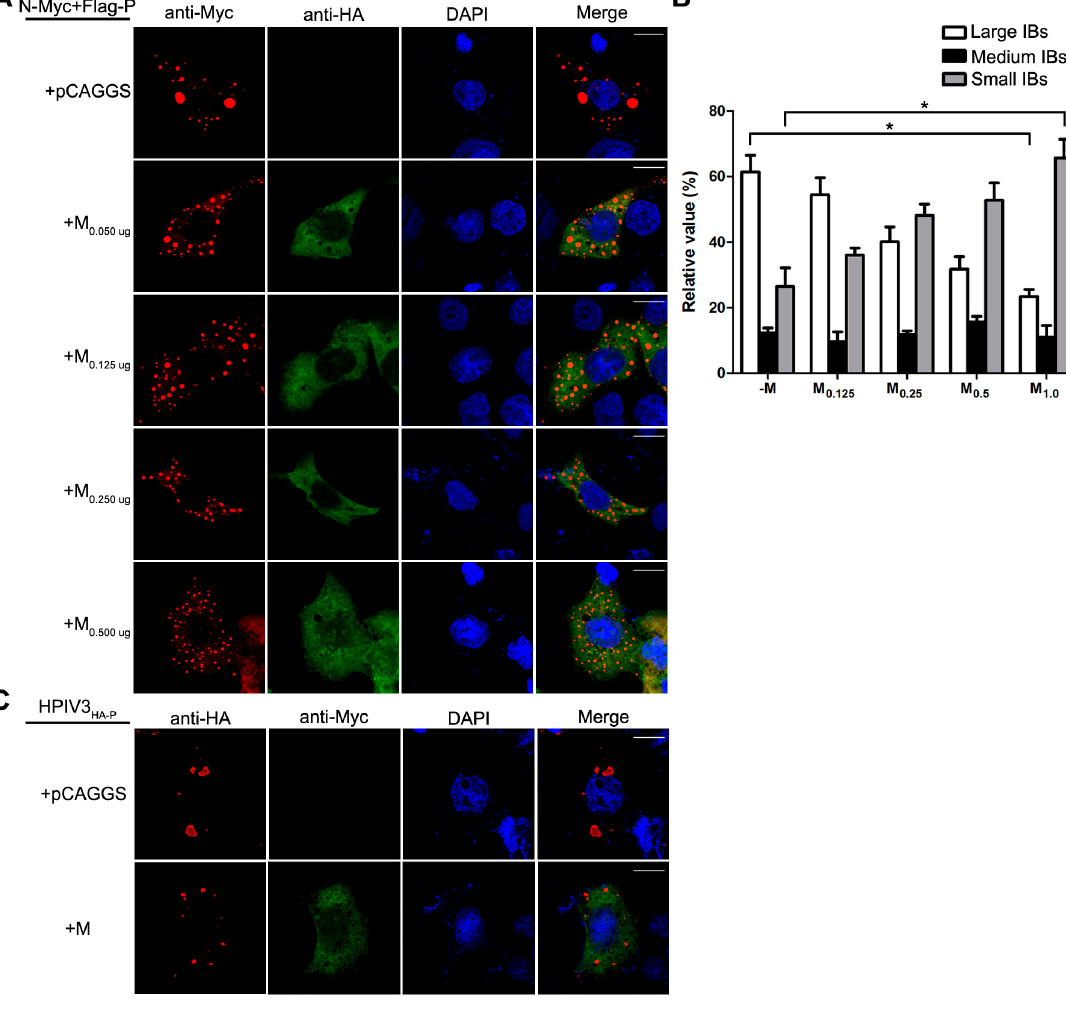
Figure 4. M reduces the formation of IBs. ( A ) the effect of M on IB formation. HeLa cells were transfected with plasmids encoding N and P alone or together with increasing amounts of pCAGGS- HA-M (50, 125, 250, 500 ng). At 24 hpt, cells were fixed and stained with antibodies against Myc and HA and visualized via confocal microscopy as described in Material and Methods. DAPI was used to stain the nuclear; Scale bar,10 μ m.( B ) the quantifications of large, medium and small IBs relative to IBs of all sizes in M transfected cells. The cross-sectional areas of IBs in ( A ) were measured. Large, medium, and small IBs were quantified in at least 50 cells for each group. The graph shows the percentages of large, medium, and small IBs to IBs of all sizes. Values are means ± standard deviations